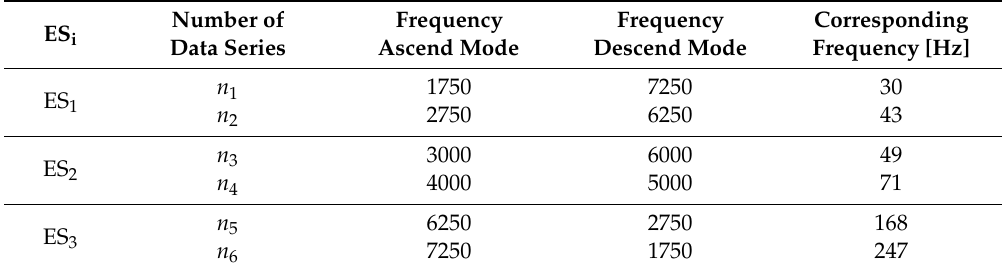
Table 3. Numbers of data series corresponding to the start and end frequencies of ES i